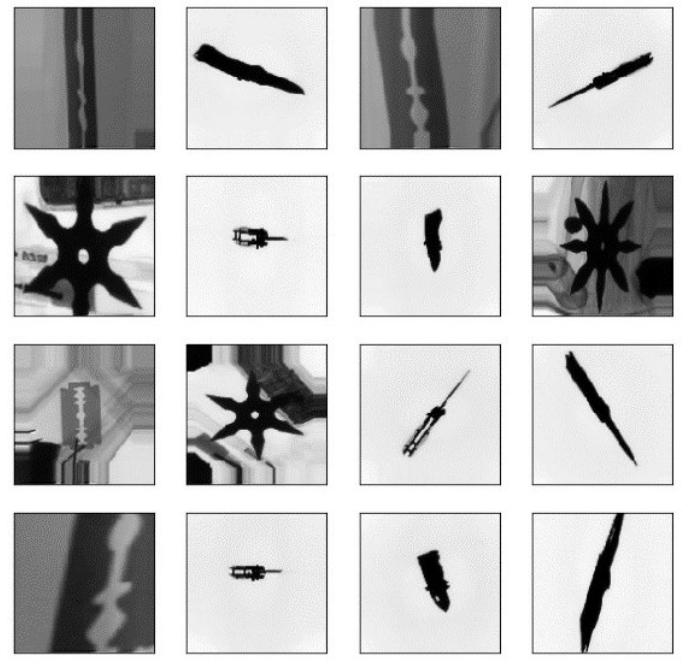
Figure 6. Image generated using ReLU activation layer after Epoch 900. The anomaly scores were calculated using the Skip-GANomaly evaluation method after training. All the test set images contained anomalous and normal images. The scatter points shown in Figure 7 illustrate the distribution of anomaly scores for all the images. Here, the red dots represent anomalous data and the blue dots represent normal